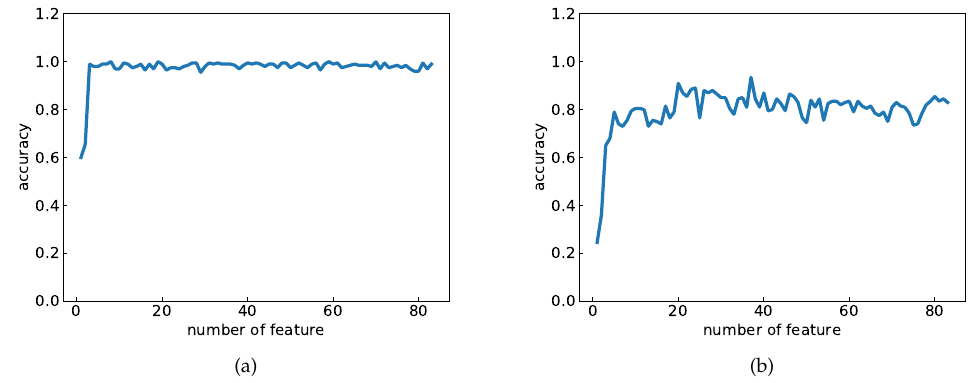
Figure 6. Variation in classification accuracy by using top k features in ( a ) the two-class problem and ( b ) four-class